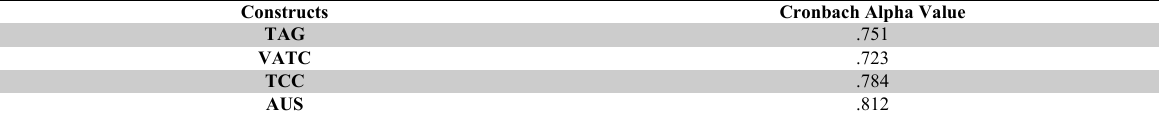
Intercoder Reliability